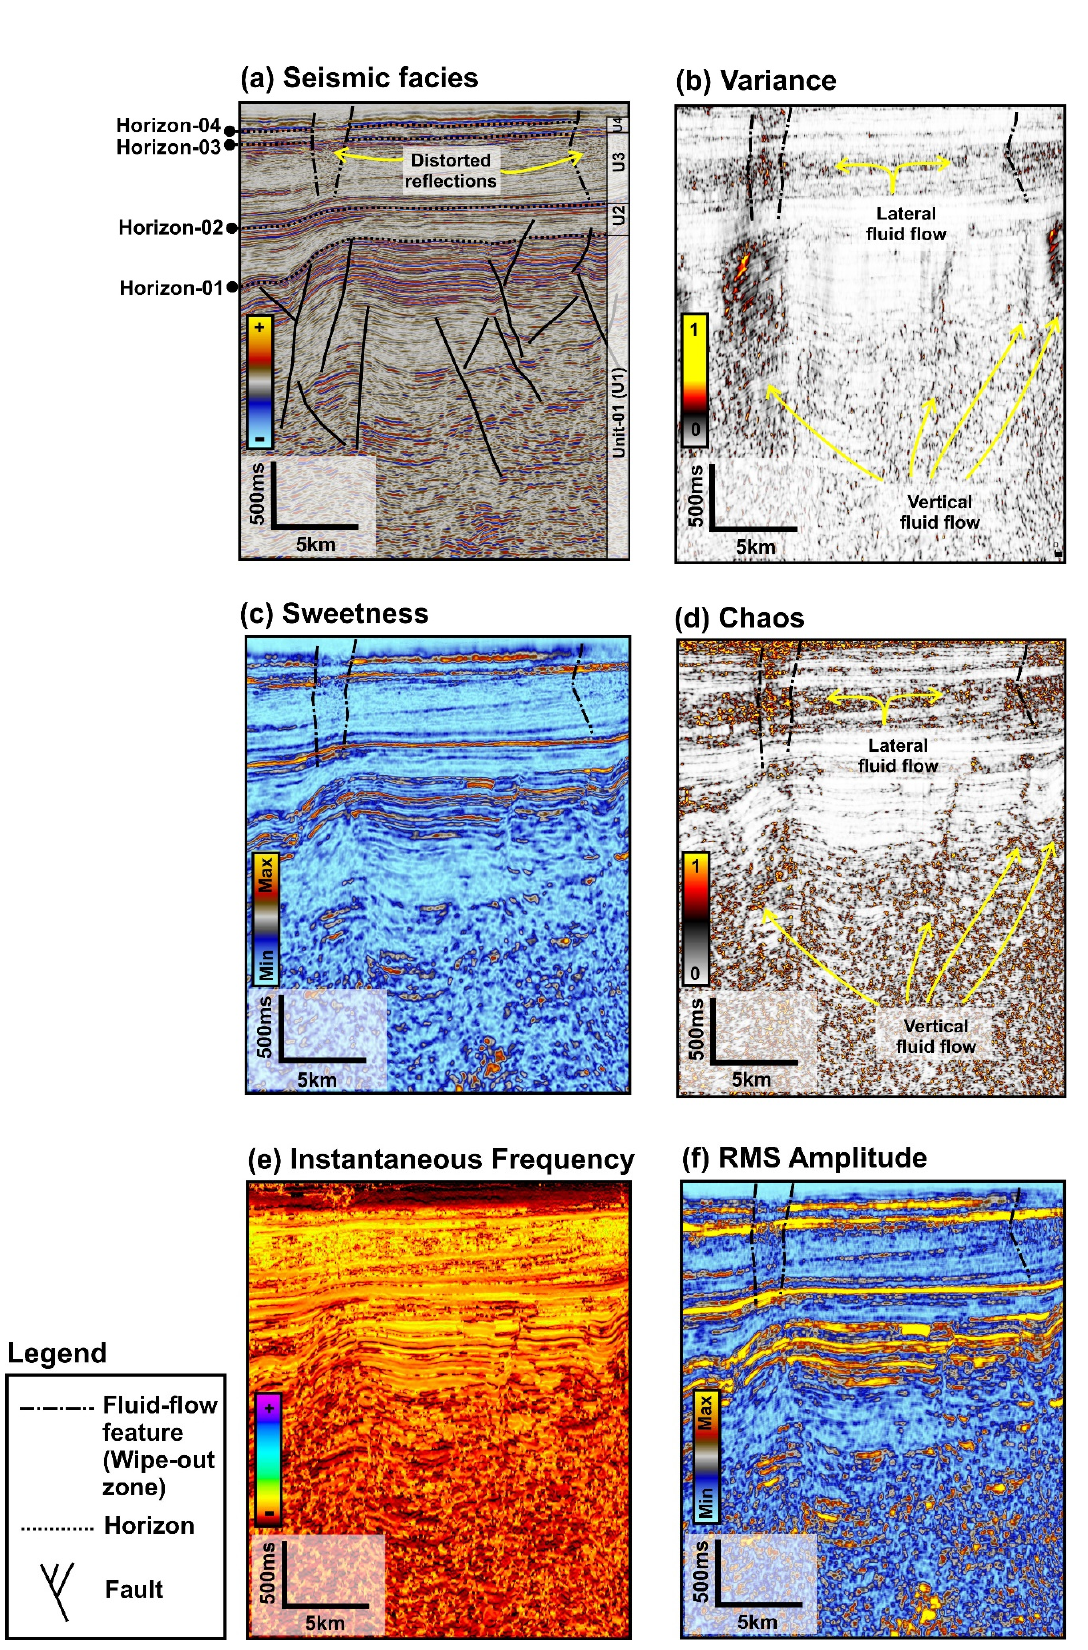
Figure 4. ( a ) Seismic facies and seismic attributes of line 3; ( b ) variance, ( c ) sweetness, ( d ) chaos, ( e ) instantaneous frequency, and ( f ) RMS amplitude, with fluid flow feature interpretation. See Figure 1a for section location.